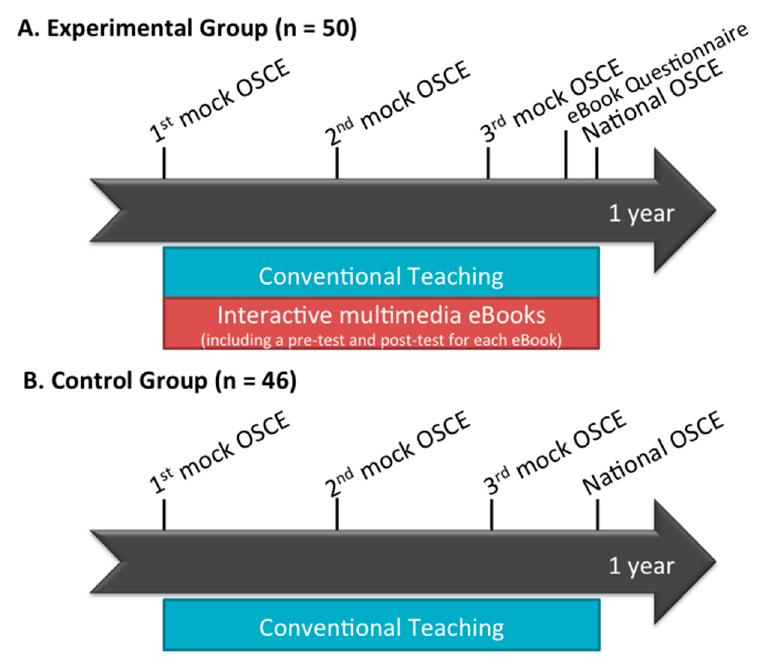
Figure 1. Schematic illustration of the experimental timeline.